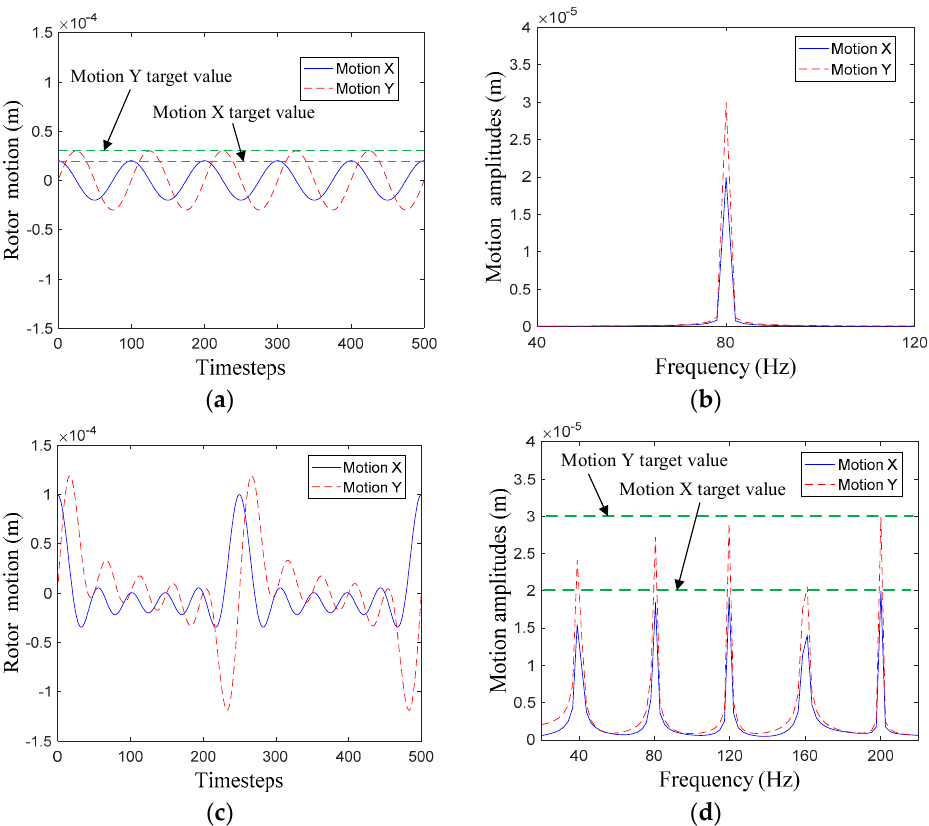
Figure 9. Whirl displacements of the rotor with SFWM and MFWM. ( a ) Time domain with SFWM. ( b ) Frequency domain with SFWM. ( c ) Time domain with MFWM. ( d ) Frequency domain with MFWM.